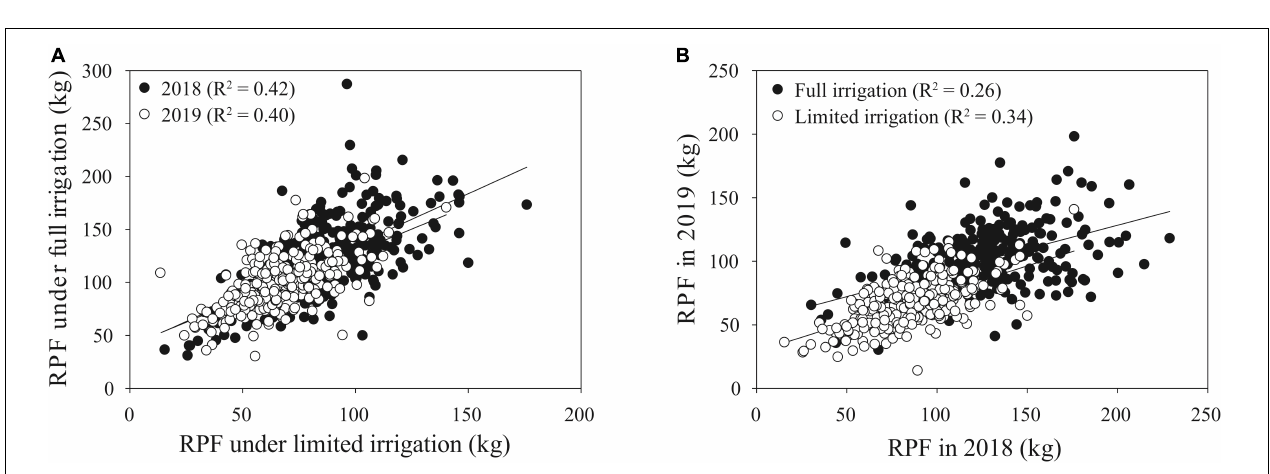
FIGURE 4 | Genotypic correlations among traits in the 2019 full-irrigation treatment, mid-flowering. Values are Spearman’s correlation coefficients. ** and *** indicate significant correlations, P < 0.01 and 0.001, respectively.